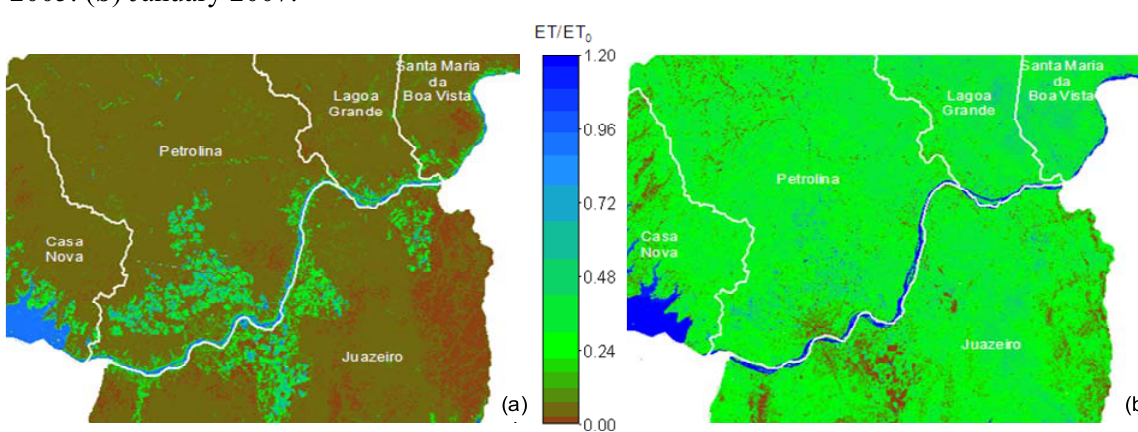
for the region comprised of the net of 0